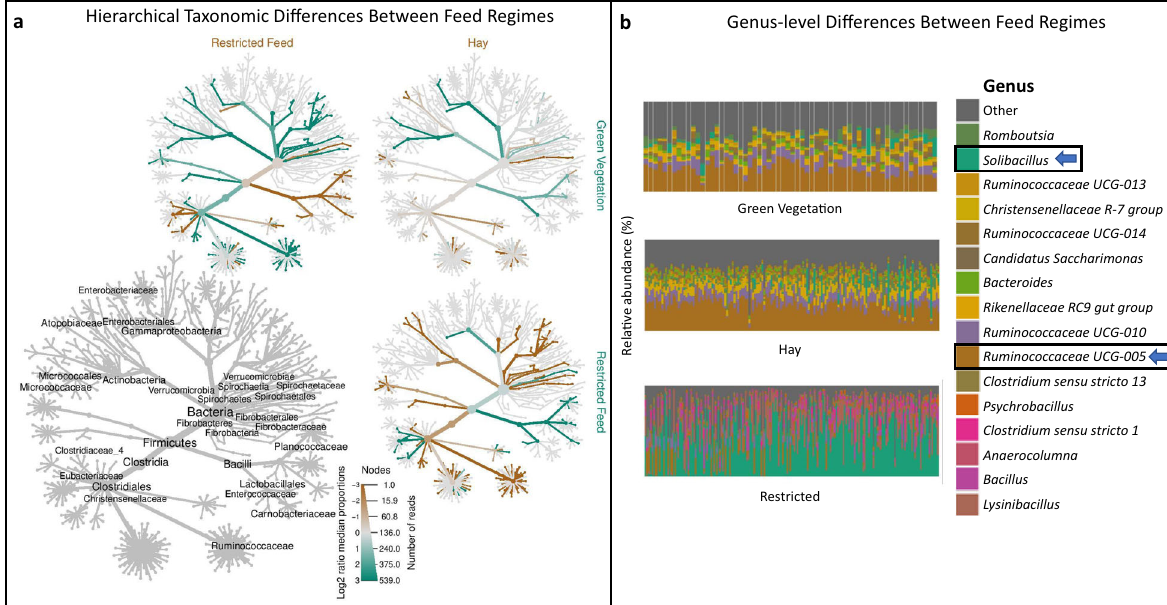
Fig. 1 Diet regime drives structural variation in the African buffalo gut microbiome. a Annotated taxonomic hierarchies show relative enrichment of taxa from the kingdom through family levels across pairwise comparisons between diets. The hierarchies with colored nodes represent pairwise comparisons between the dietary regimes listed on the x -axis and y -axis. Lineages that are highlighted in brown or green indicate log 2-fold increase in median abundance of that lineage in the x -axis group or the y -axis group, respectively. The bottom left hierarchy provides a key with labels for all taxa that signi fi cantly differed in at least one of the pairwise comparisons (false discovery rate-adjusted Wilcoxon rank sum q < 0.05), with size of labels corresponding to number of genera contained in that node. b Relative abundance of the most common genera across individuals in each diet regime. Under the restricted regime, 72% of samples were dominated by genus Solibacillus . In contrast, Ruminococcaceae UCG-005 was the most abundant genus in 88% of the samples from the hay regime, and 90% of the samples from the green vegetation